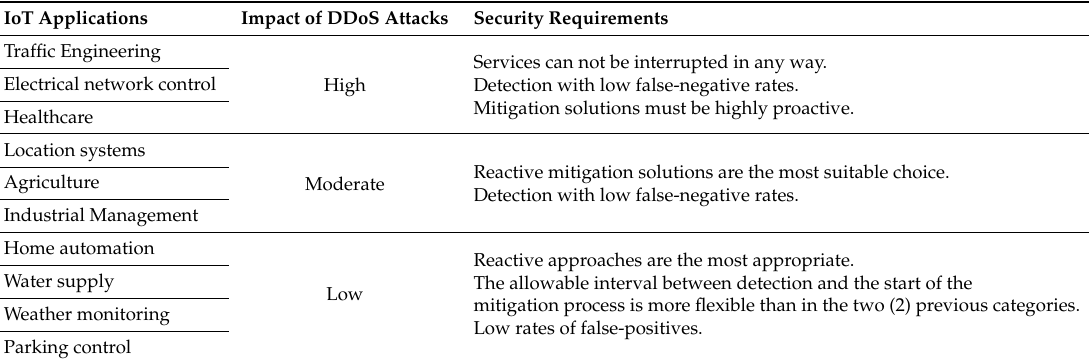
Table 1. Classification of Internet of Things (IoT) applications based on your security requirements